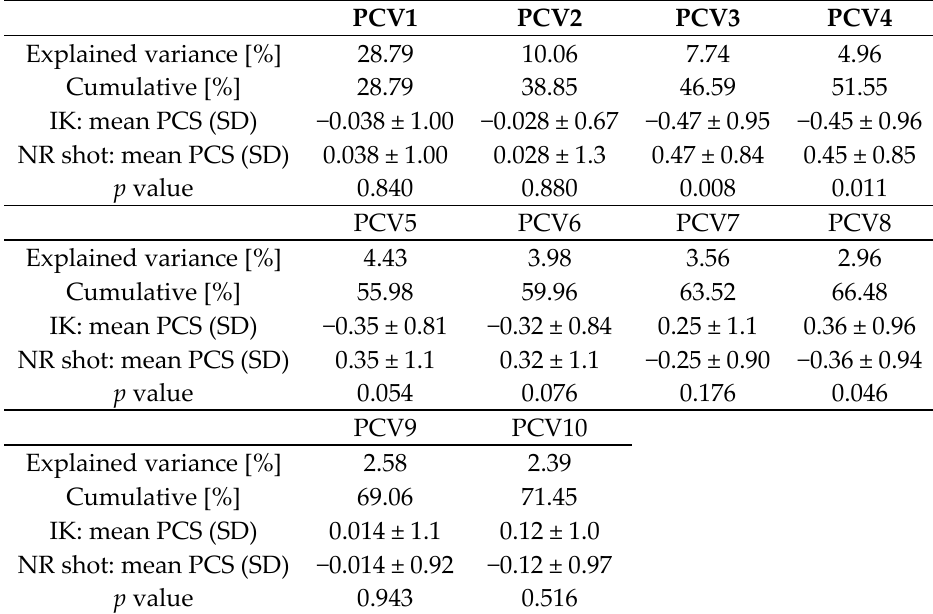
Table 2. Results of the principal component analysis (PCA) in EMG